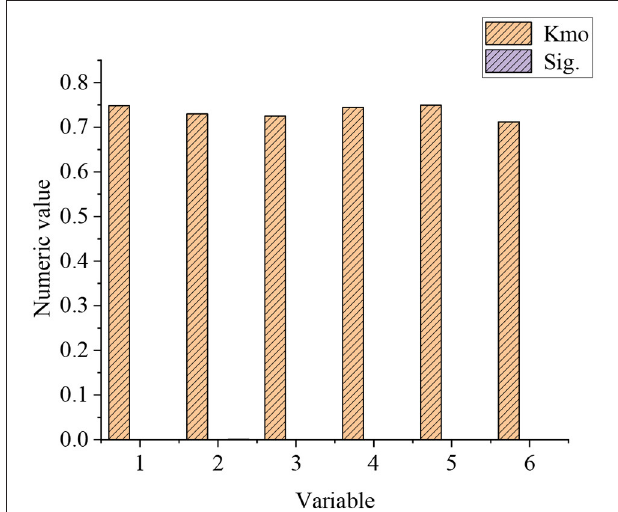
FIGURE 7 | KMO test of the whole QS.